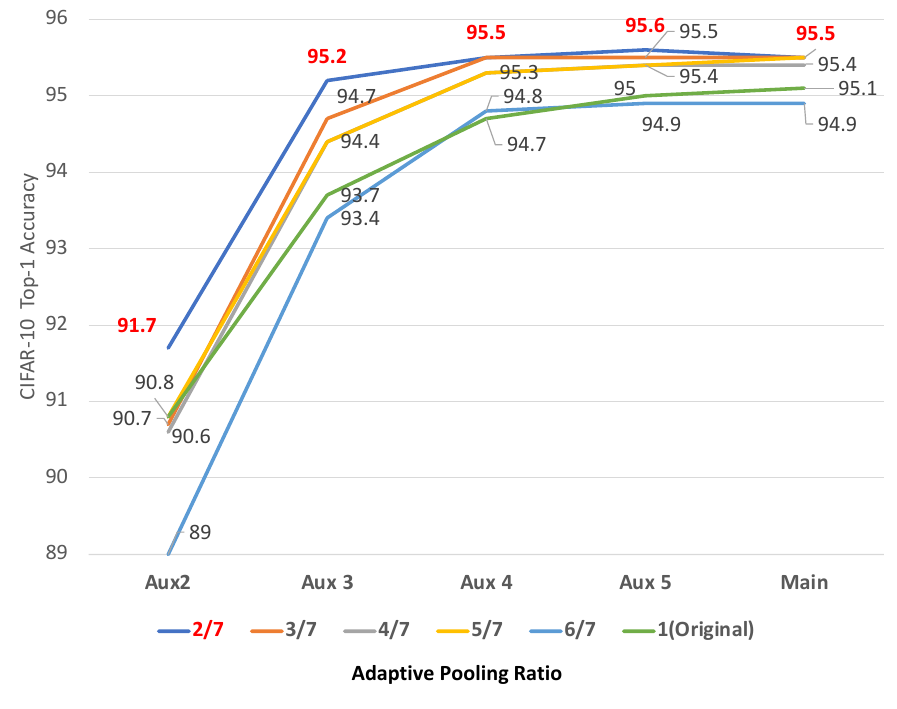
Figure 5. Accuracy when adaptive pooling size is varied. Original size is 224 ×